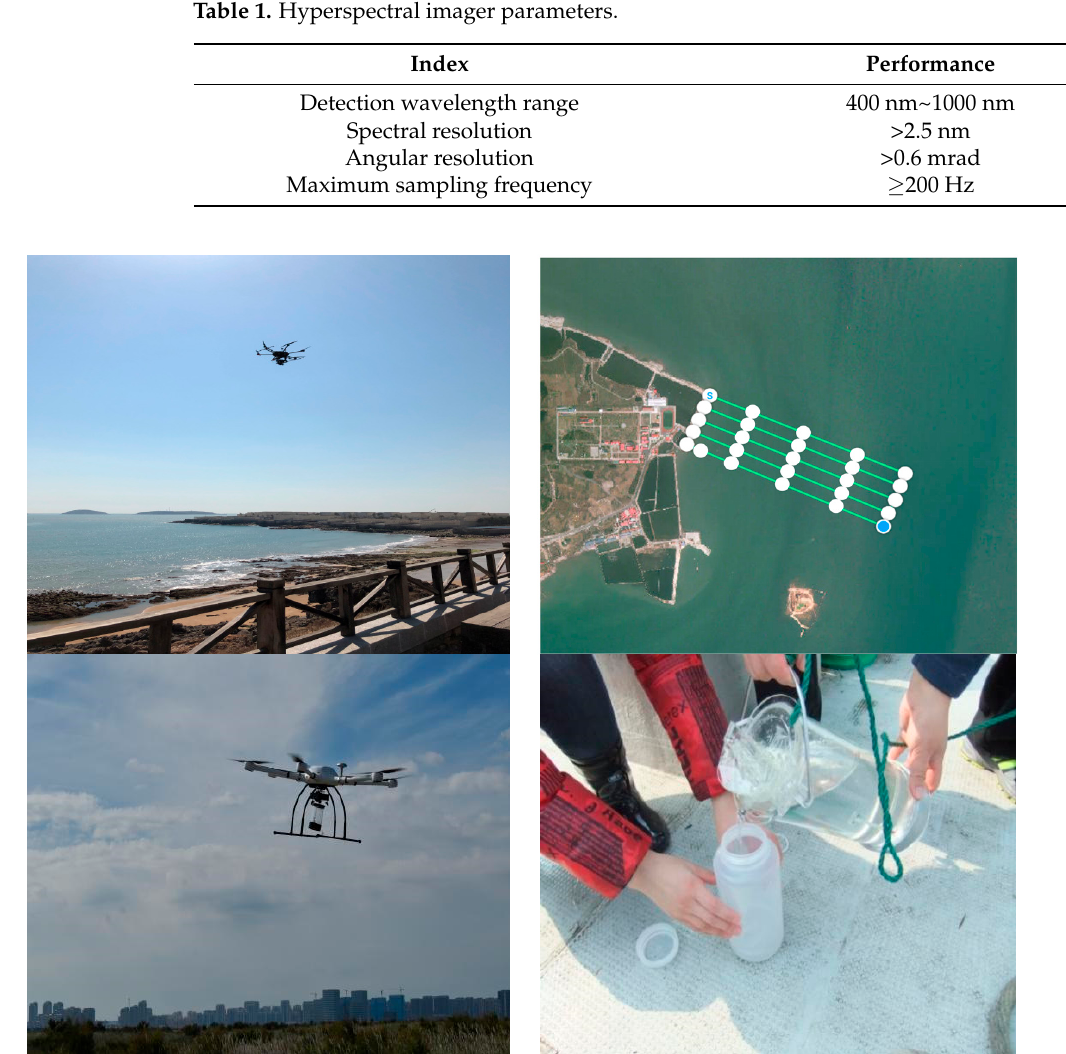
Figure 2. Operation map, route planning, and water sample collection diagram.